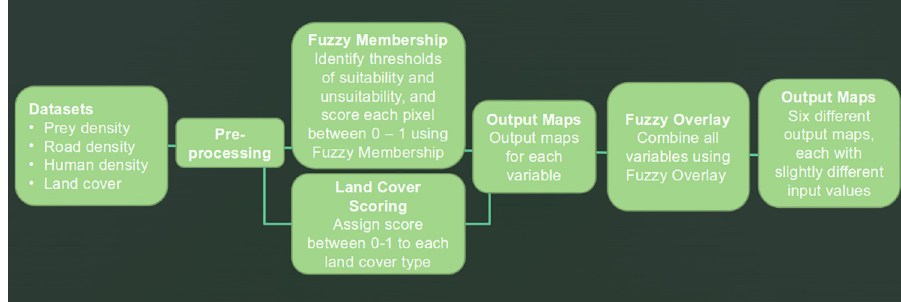
Fig 2. Flowchart of process. A summary of the analysis process, from input datasets to output maps. Note there are output maps for each variable individually, and then further output maps of all four variables combined using fuzzy overlay.